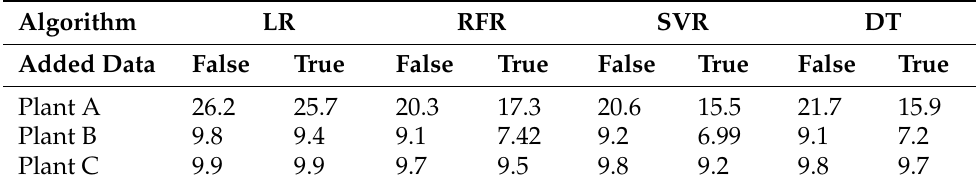
Table 4. Average root mean square error ( RMSE ) of the evaluation data of all prediction models trained to output DC voltage using different models and different input data (without or with the added